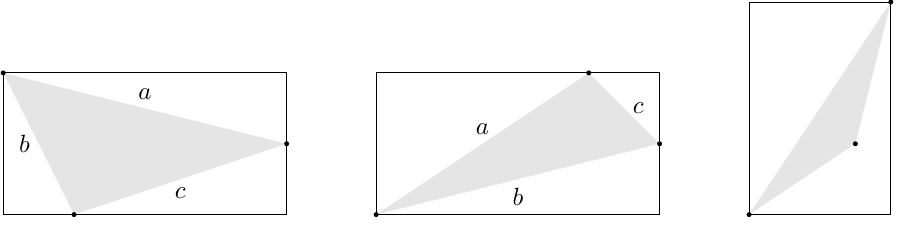
Figure 1: Two admissible triangles and one non-admissible